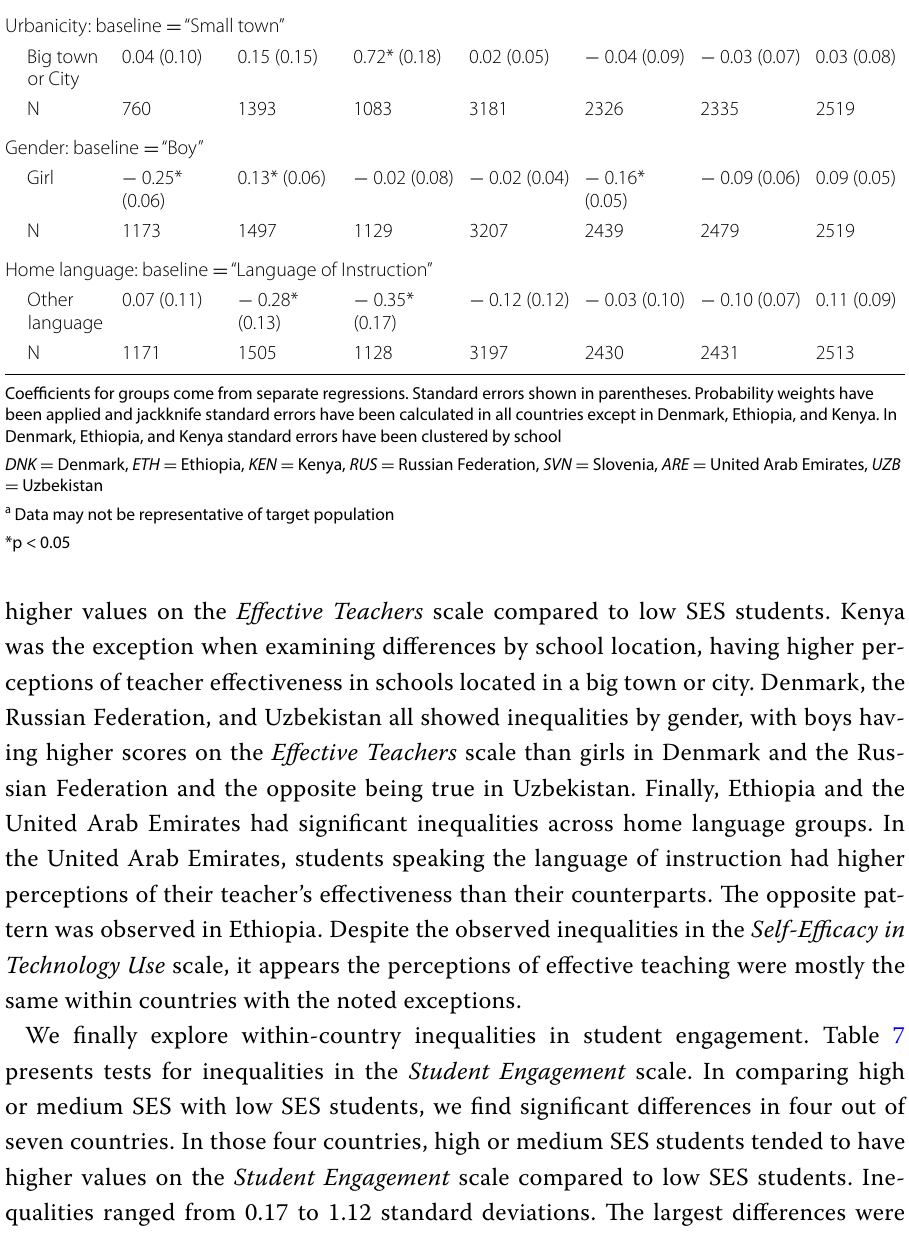
Table 7 Inequalities in student engagement scale